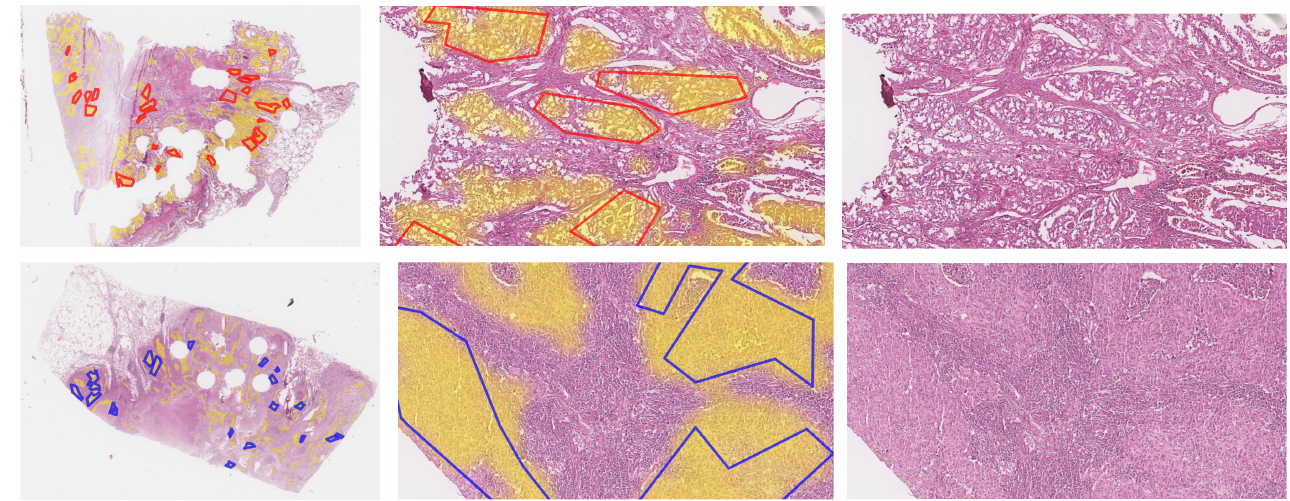
Figure 3. Whole slide images of test sections ADC1 and SqCC7, and zoomed-in images overlaid with original annotations of tumor areas (red lines: ADC, blue lines: SqCC) and heatmap of segmentation (Seg1, yellow filling). Images of all sections can be found in the Appendix A in Figure A2.